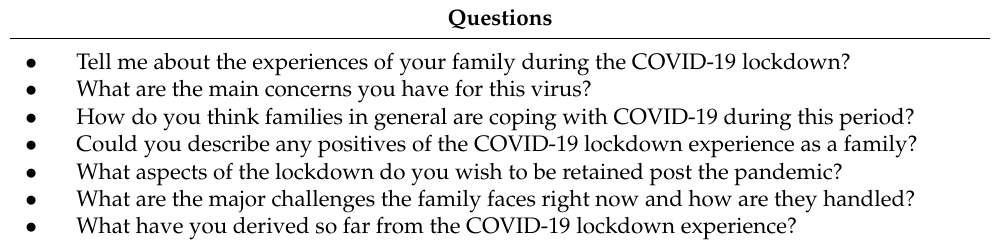
Table 2. Semi-structured interview